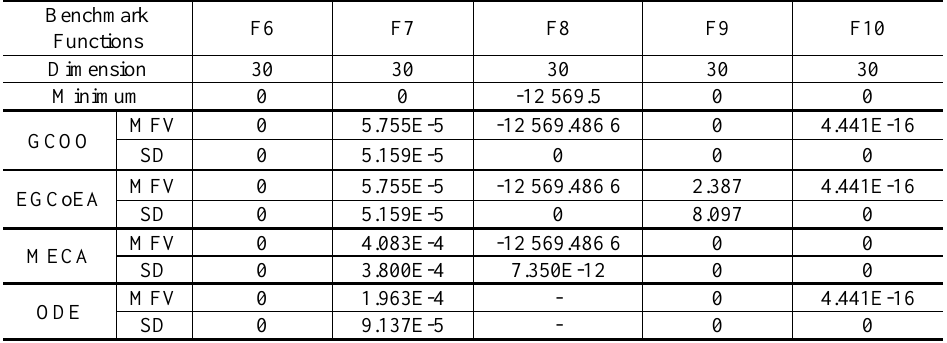
Table 3 Mean Function Values (MFV) and Standard Deviations (SD) of 50 Independently Random Experiments F6~F10 Benchmark